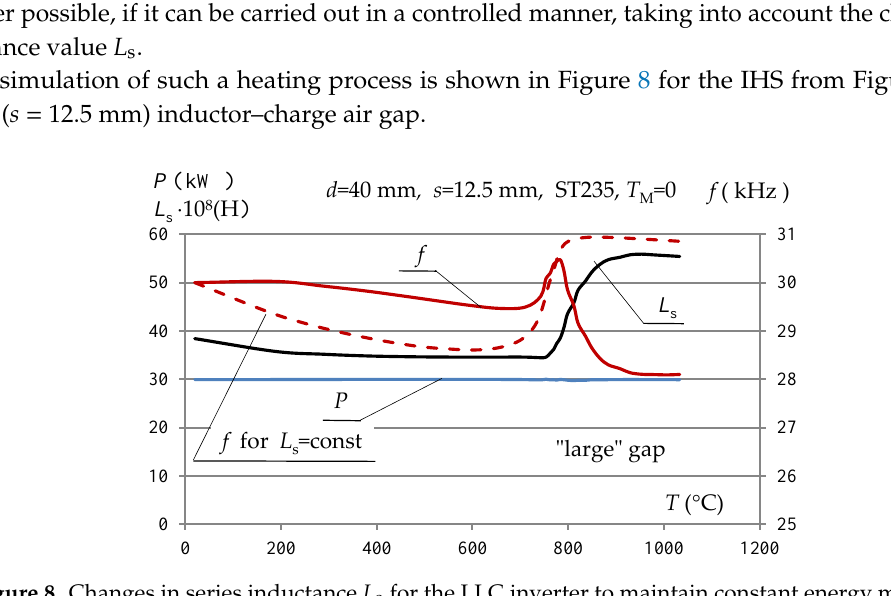
Figure 7. Comparison of relative changes in resonance equivalent resistance of the load as a function of the charge surface temperature during heating by an inverter with different types of resonance system: ( a ) “large” gap and ( b ) “small” inductor–charge gap.